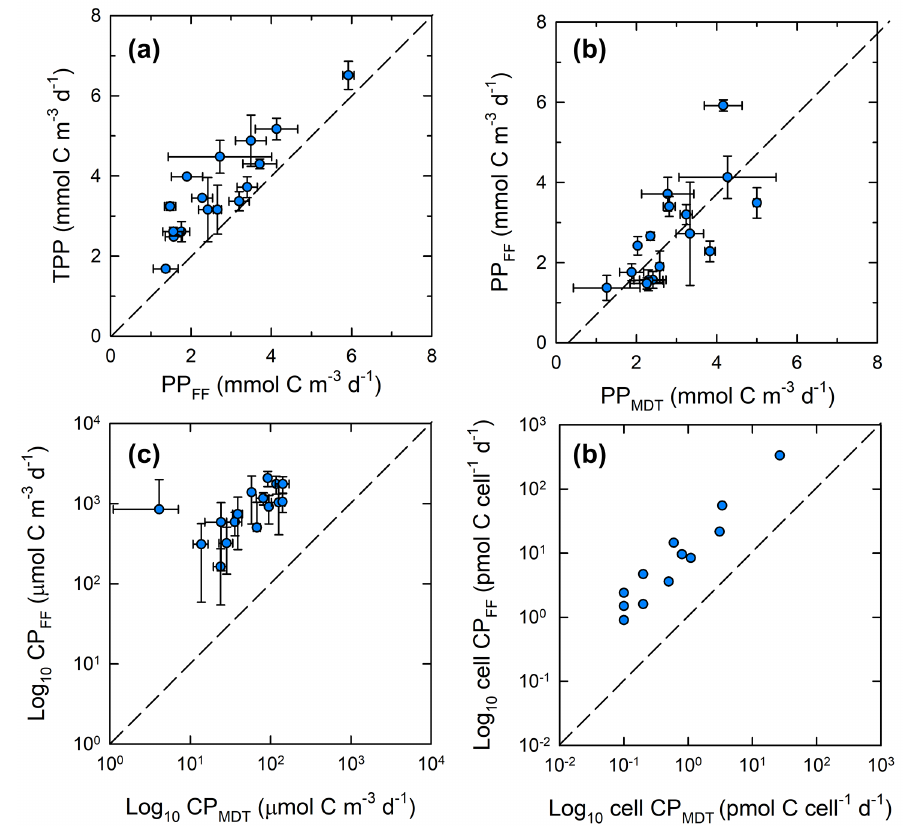
Figure A1. Scatterplots of (a) total particulate production (TPP) and primary production from the difference technique (PP FF ), (b) primary production from the micro-diffusion technique (PP MDT ) and difference method (PP FF ), (c) log-normalised CaCO 3 production from the micro-diffusion technique (CP MDT ) and difference method (CP FF ), and (d) log-normalised cell-normalised rates (cell-CP) from the micro- diffusion technique (cell-CP MDT ) and difference method (cell-CP FF ). Dashed lines in all panels indicate